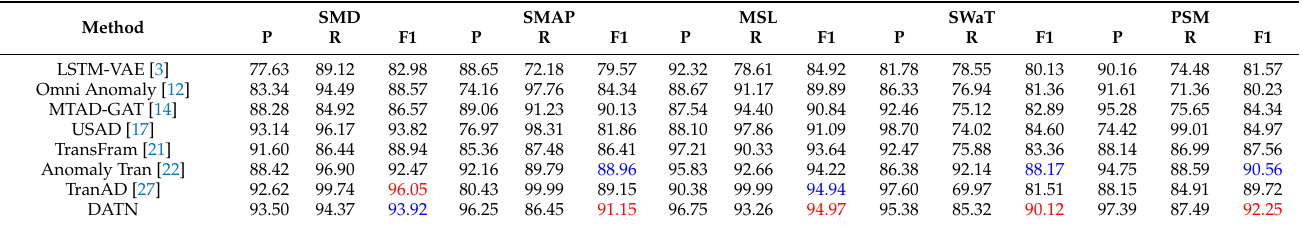
Table 2. Performance comparison of the baseline methods (as %, red: best, blue: second best).